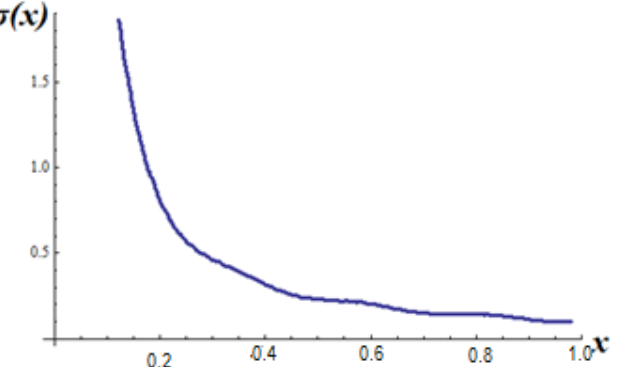
Figure 13. The distribution of the stress Σ ( x ) in the initial space.